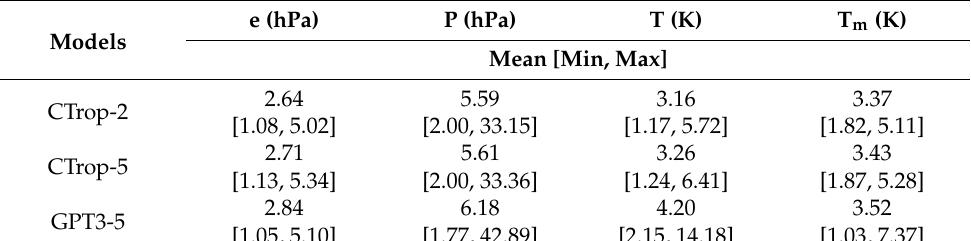
Table 4. Statistic of the RMS of different resolutions of the CTrop model compared with the GPT3-5 model.